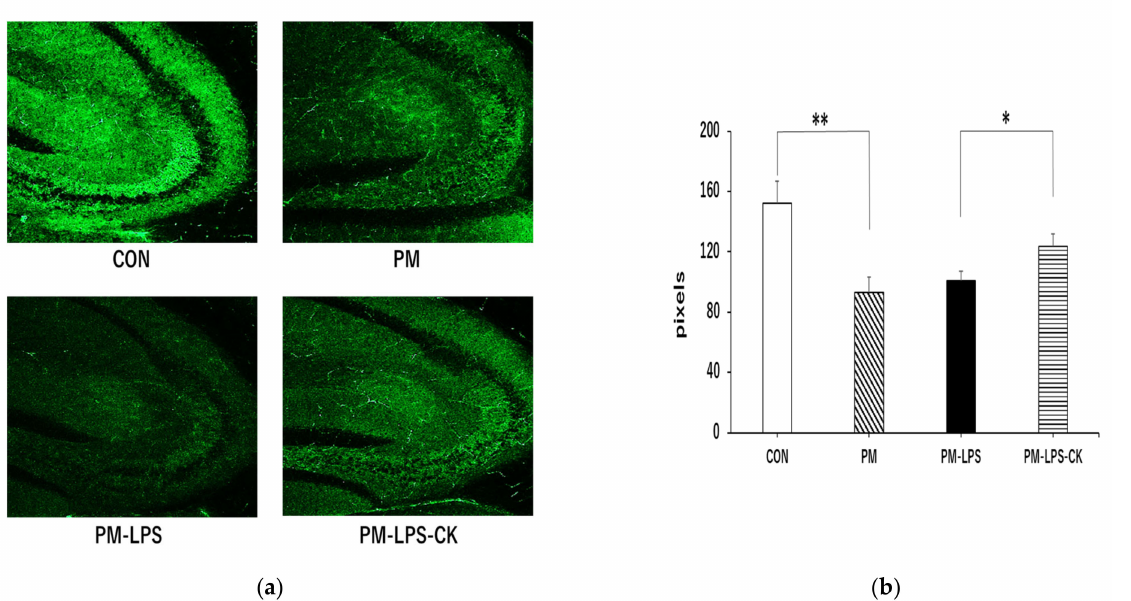
Figure 6. Effects of dried C. kawachiensis peel powder on synaptophysin immunoreactivity in the hippocampus of the 8-day group. ( a ) Representative synaptophysin antibody pictures stained with anti-synaptophysin antibody. ( b ) Quantitative analysis of the area of synaptophysin-positive signals using ImageJ software. Values are means ± SEM. Symbols show significant differences for the following conditions: CON vs. PM (** p < 0.01), and PM–LPS vs. PM–LPS–CK (* p < 0.05). The number of samples in each group is as follows: CON: n = 12, PM: n = 12, PM–LPS: n = 11,